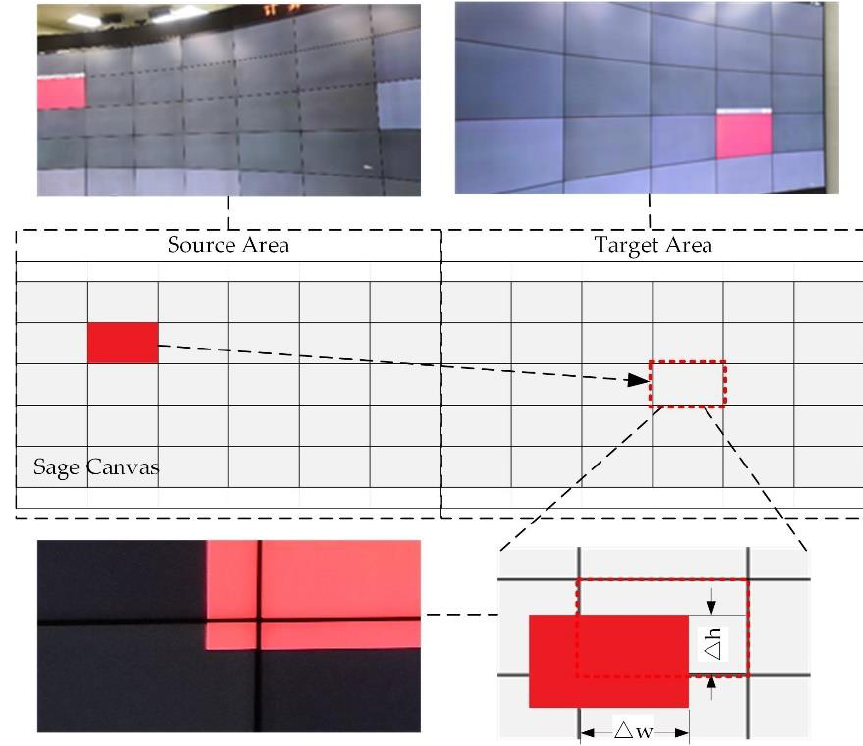
Figure 8. Movement Figure 8. Movement task.